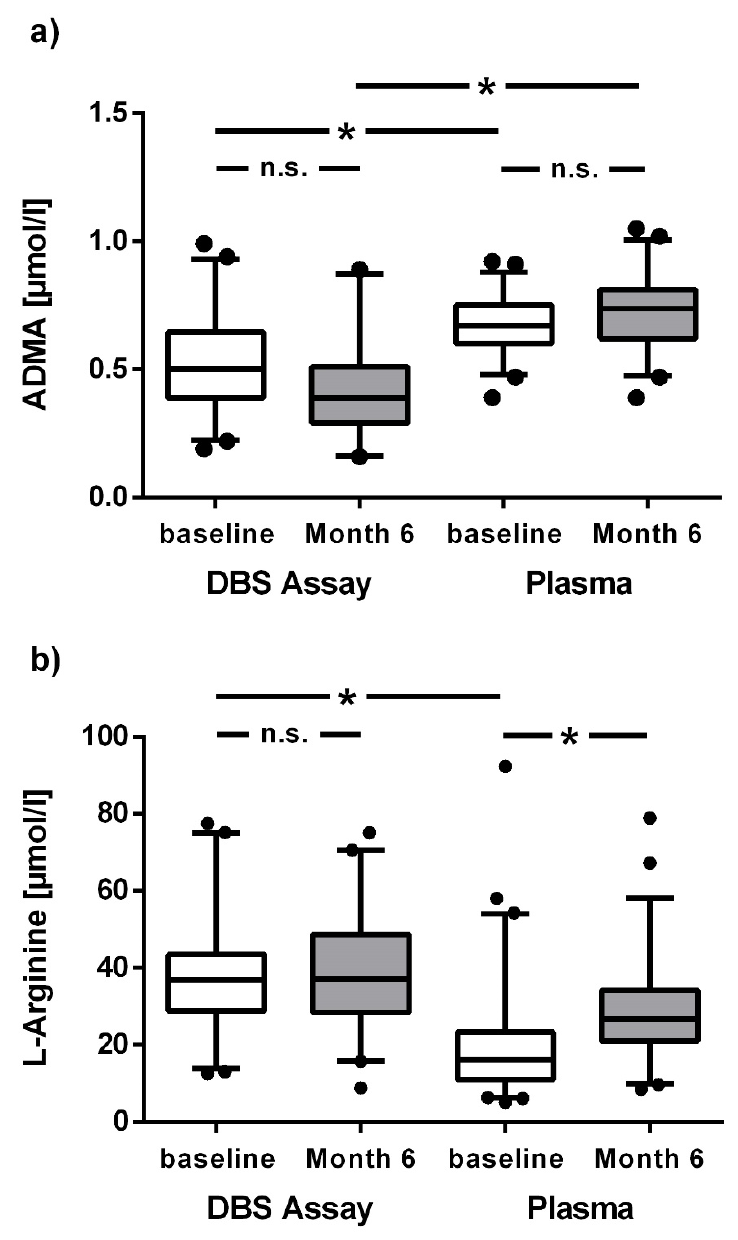
Figure 5. Box plots representing concentrations of ADMA and L-arginine at baseline and after 6 months of chronic intermittent hypoxia (CIH). ADMA ( a ) and L-arginine ( b ) were measured from dried blood spots and plasma in individuals exposed to six months of chronic intermittent hypoxia (CIH). * p < 0.05 between groups.